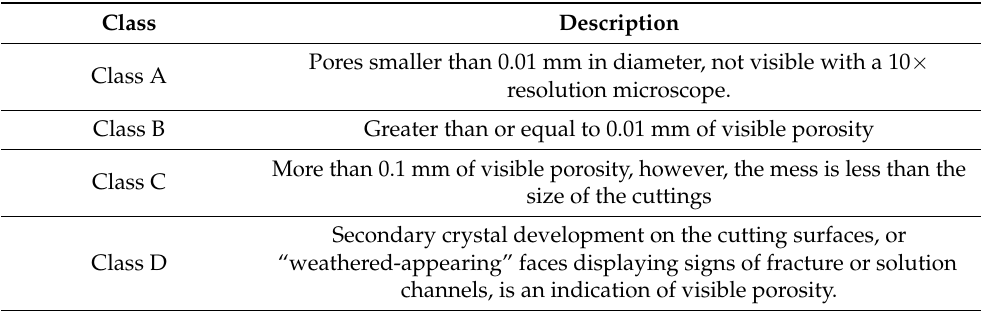
Table 2. Visible pore size classification of carbonate